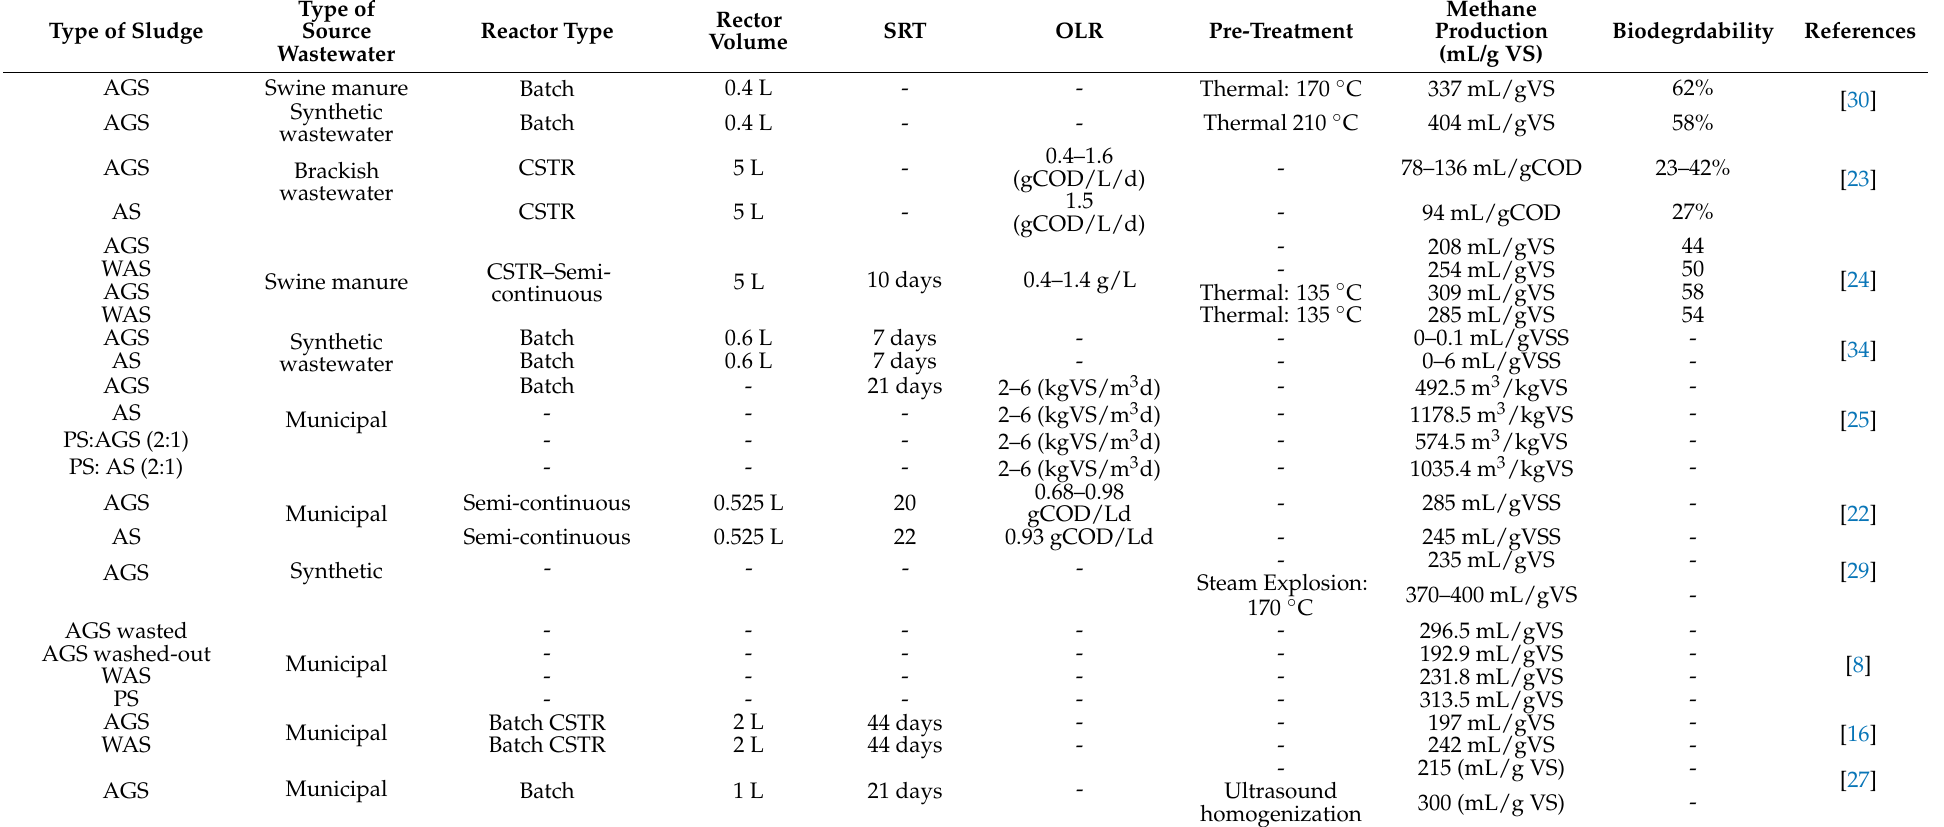
Table 5. Anaerobic digestion of different AGS and AS